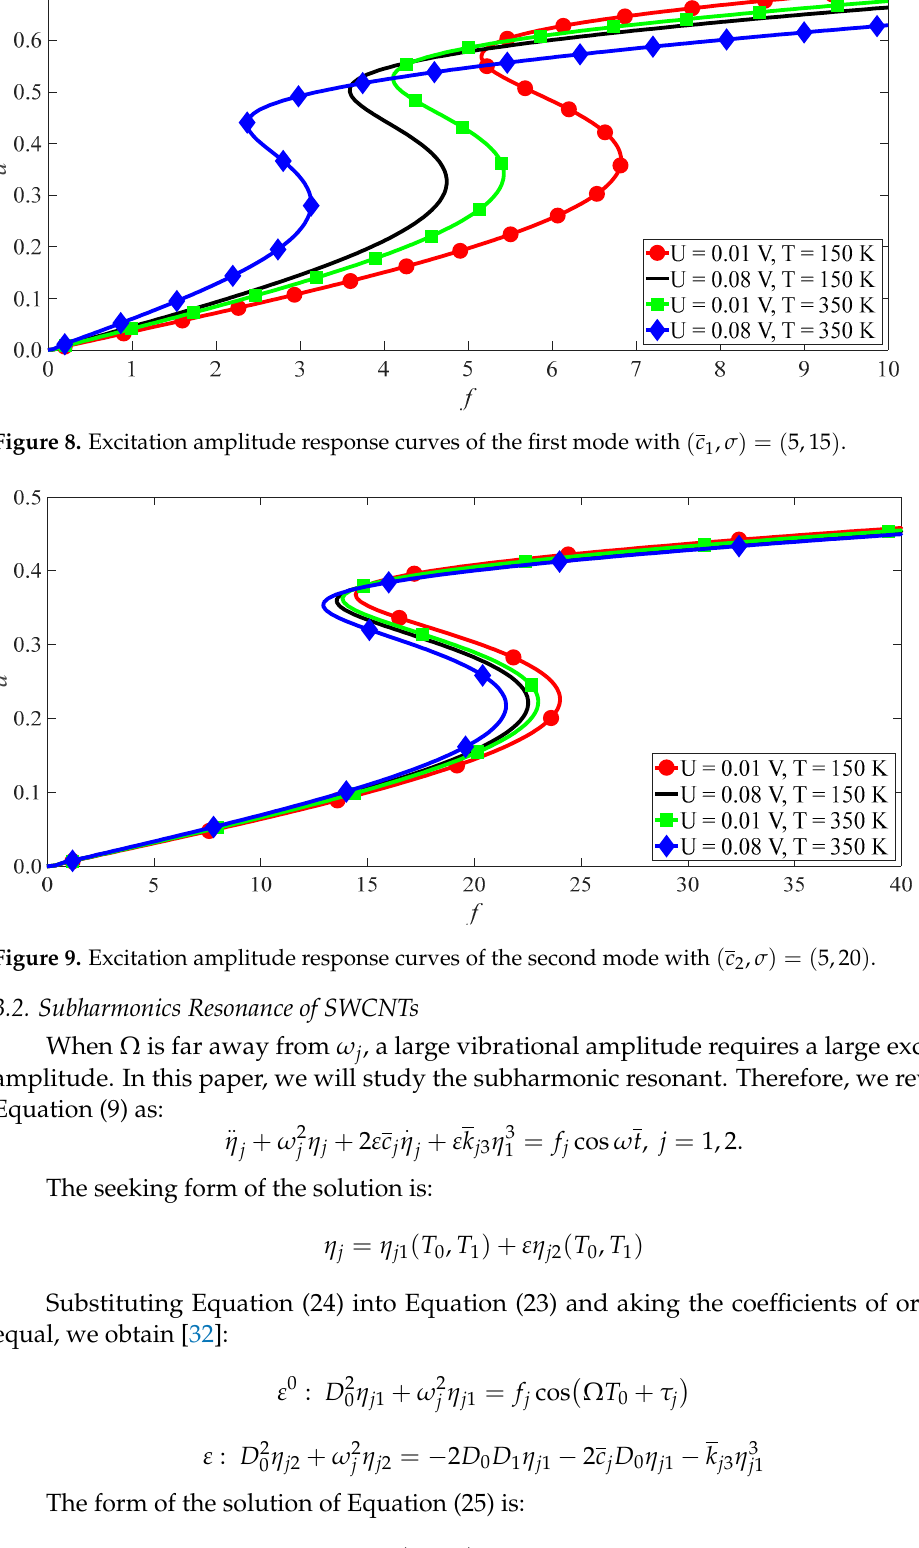
Figure 7. Frequency − response curves of the second mode with